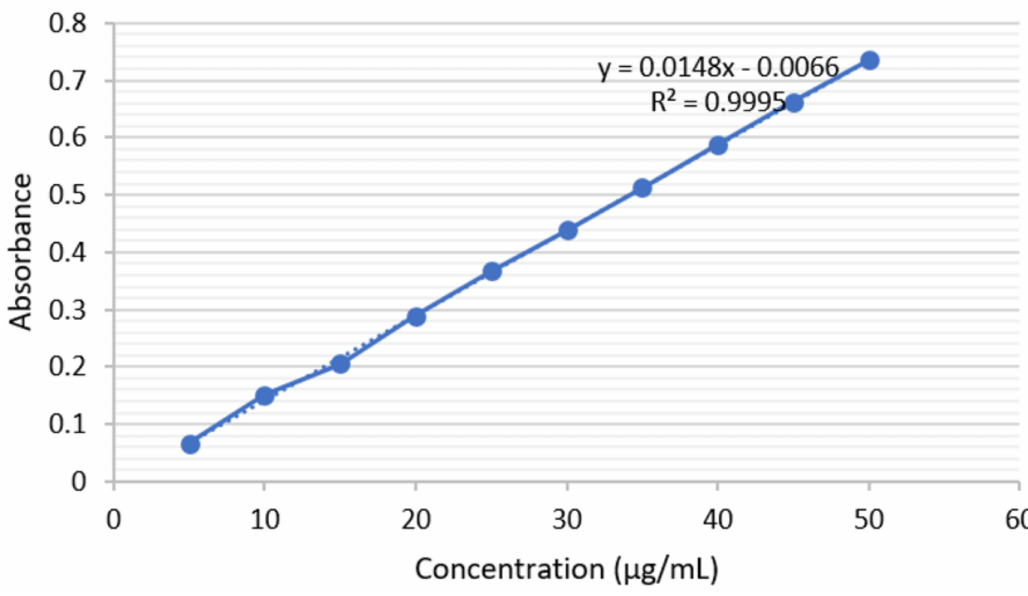
Figure 5. Calibration curve of standard scopoletin at 344 nm.